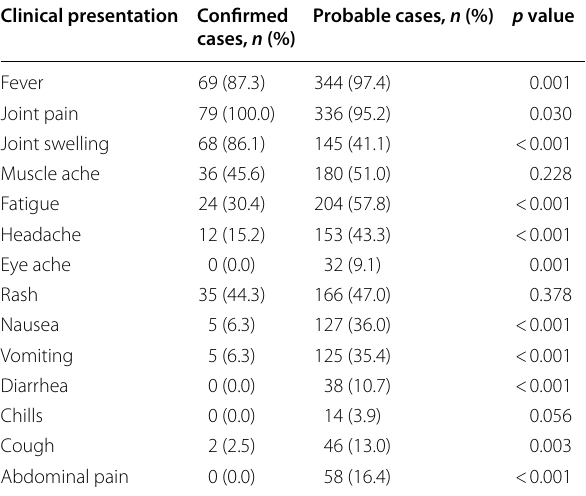
Table 3 Clinical presentations of the chikungunya patients according to diagnosis ( n 432) = Clinical presentation Confirmed Probable cases, n (%) p cases, n (%)